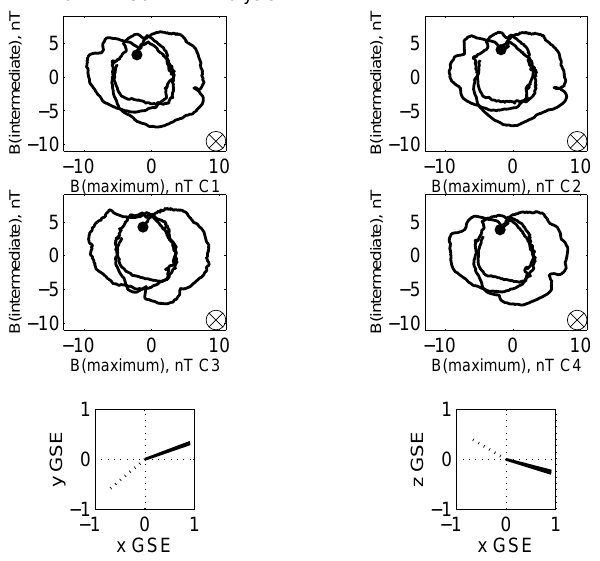
Fig. 3. MVA analysis for the interval 04:04:00 UT–04:04:30 UT. The top four panels are hodograms derived from each of the four spacecraft. The cross symbol indicates that the average magnetic field is directed into the page. The dot on the trace indicates the start point. The bottom two points show the orientation of the four minimum variance directions (solid) and the magnetic field (dotted) projected into the x − y (left) and x − z (right) GSE